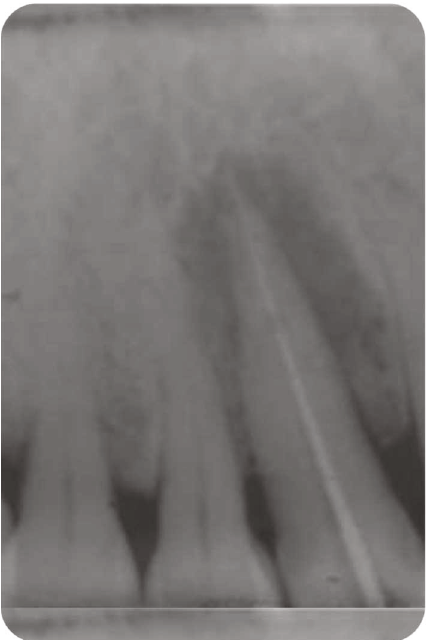
Figure 3: Initial state of the periodontal area.